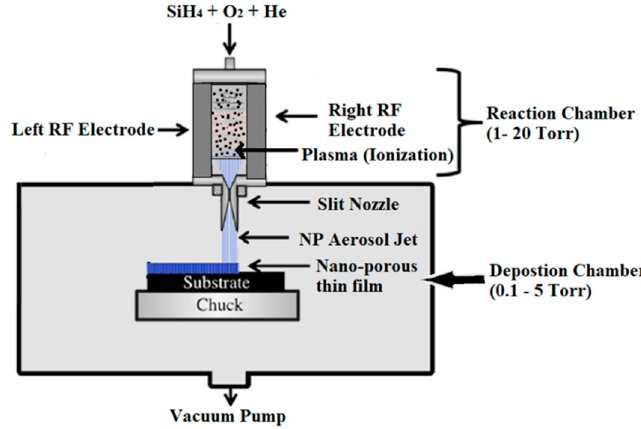
Figure 1. Aerosol spray deposition assembly.